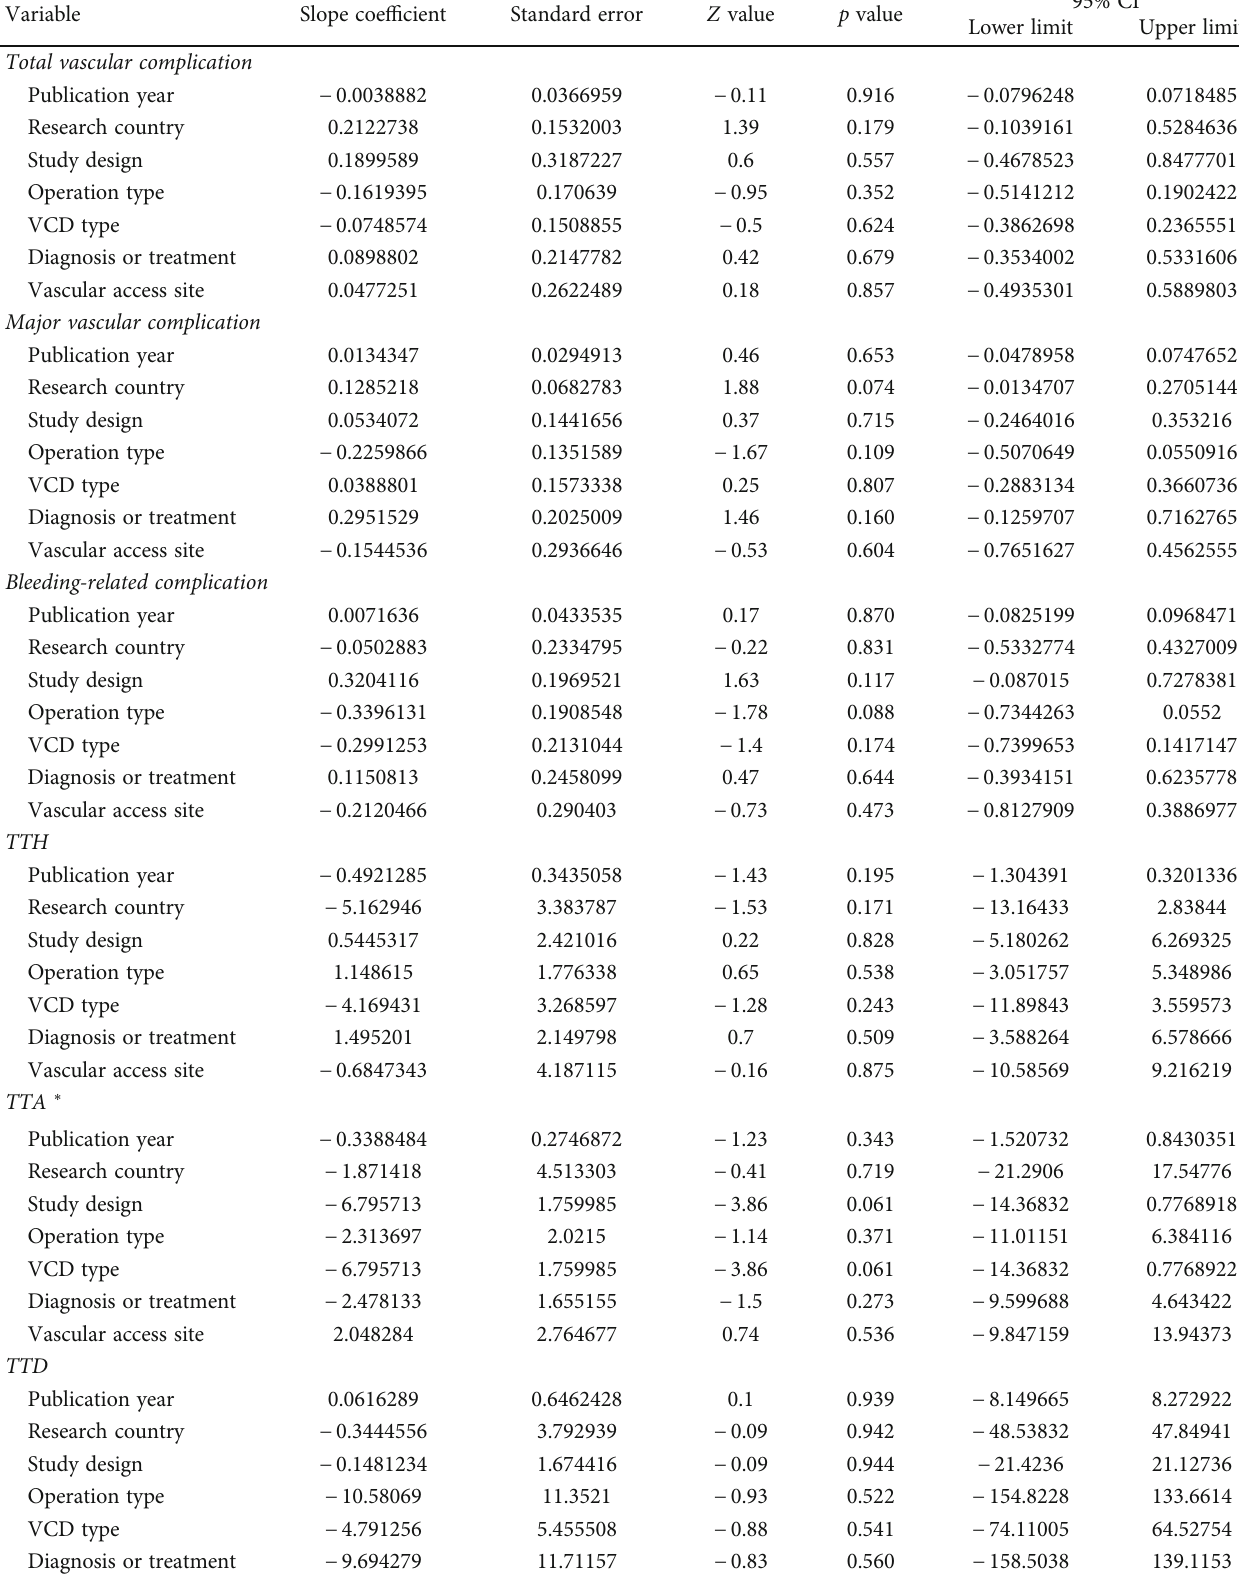
Table 3: Results of meta-regression analysis for outcome